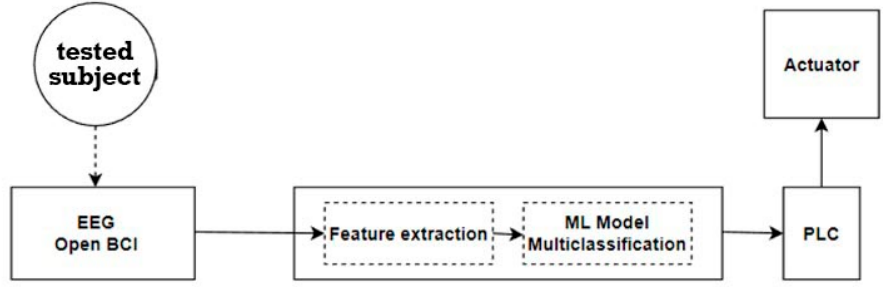
Figure 4. Flow chart of the experiment with all of its parts.